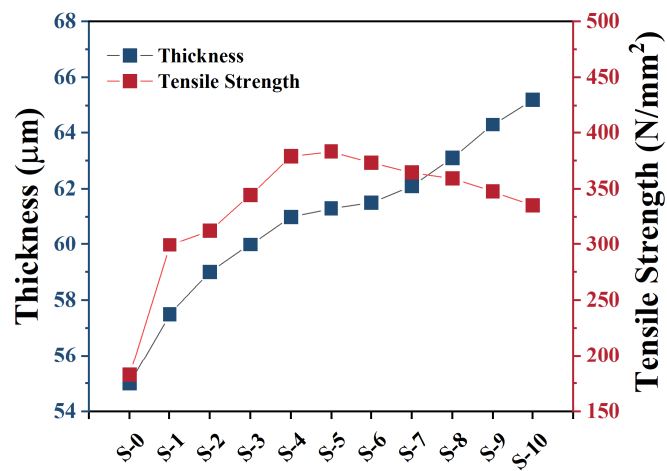
Figure 5. Thickness and tensile strength of hair before and after dyeing process.